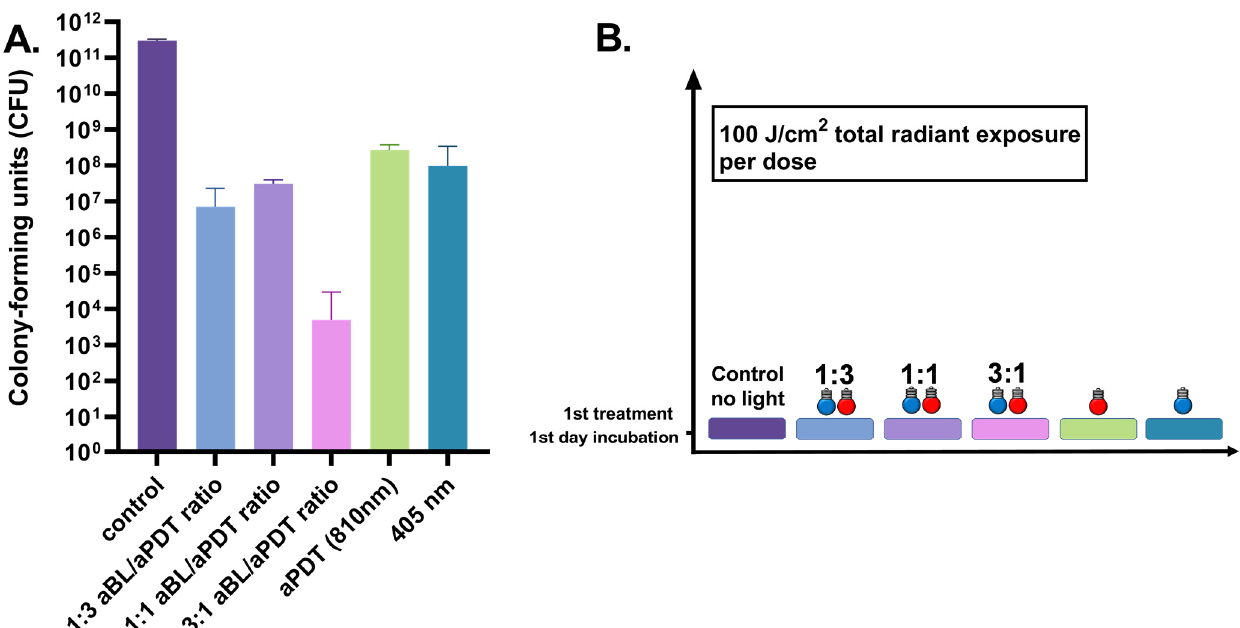
Figure 1. ( A ). Effects of different irradiance ratios of aBL and aPDT in the dual-light aPDT system in one-day S. aureus biofilm. One-day S. aureus biofilm, single dose, aBL vs. dual-light 1:3 aBL/aPDT ratio, p = 0.0022; aBL vs. dual-light 1:1 aBL/aPDT ratio, p = 0.015; aBL vs. dual-light 3:1 aBL/aPDT ratio, p = 0.0022; aPDT vs. dual-light 1:3 aBL/aPDT ratio, p = 0.0022; aPDT vs. dual-light 1:1 aBL/aPDT ratio, p = 0.015; aPDT vs. dual-light 3:1 aBL/aPDTratio, p = 0.0022. aBL vs. aPDT, p = 0.046; dual-light aPDT: 1:3 aBL/aPDT ratio vs. 1:1 aBL/aPDT ratio, p = ns; 1:3 aBL/aPDT ratio vs. 3:1 aBL/aPDT ratio, p = ns; 1:1 aBL/aPDT ratio vs. 3:1 aBL/aPDT ratio; p = ns. The y -axis displays the median of CFUs. Six assays were performed for each experiment, and the control biofilm was performed in three assays. The 95% confidence interval (CI) is presented by using t-bars. ( B ). A schematic representation of the experiment.